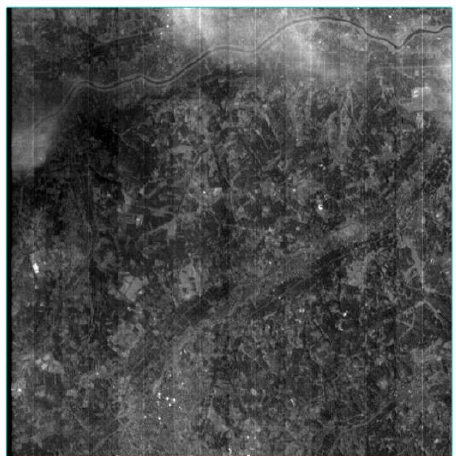
Figure 1. Yaogan-14 satellite original image